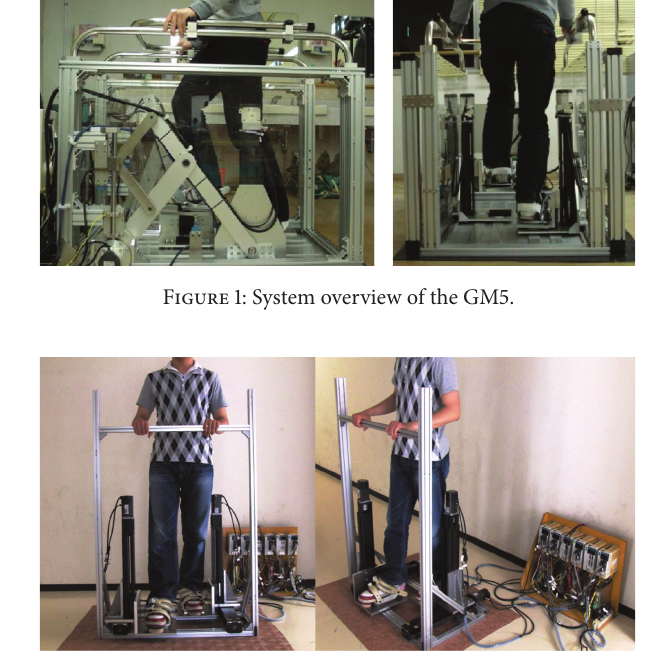
Figure 2: Mechanism of the footpad of the